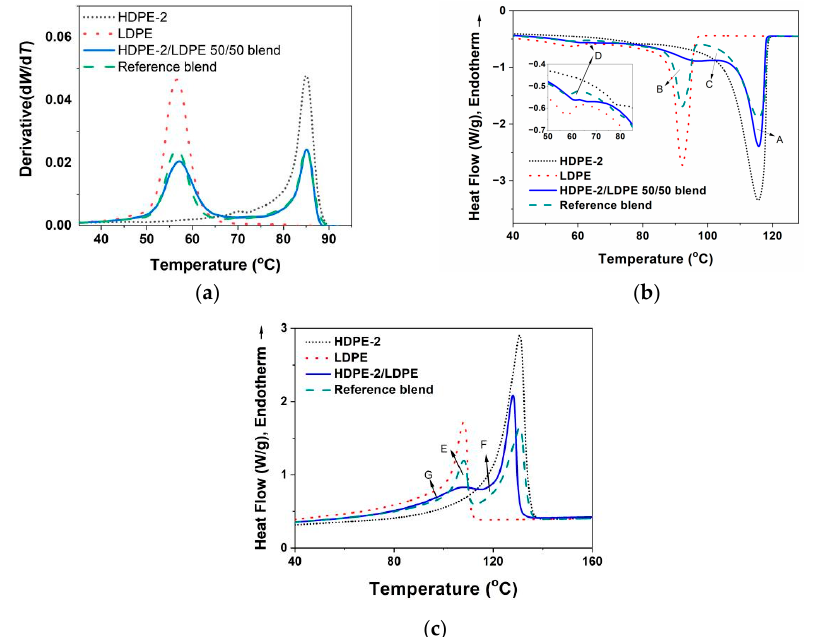
Figure 5. CRYSTAF pro fi les of the neat HDPE-2, the neat LDPE, and the HDPE-2/LDPE 50/50 blend ( a ), DSC cooling curve ( b ) and second heating curve ( c ) of the HDPE-2/LDPE 50/50 blend compared with neat component curves (do tt ed line) and calculated reference blend curves (dashed line). “A”–“G” in the figures indicates the area between the HDPE-2/LDPE 50/50 blend curve (solid line) and the reference blend curve (dashed line) at the corresponding locations.